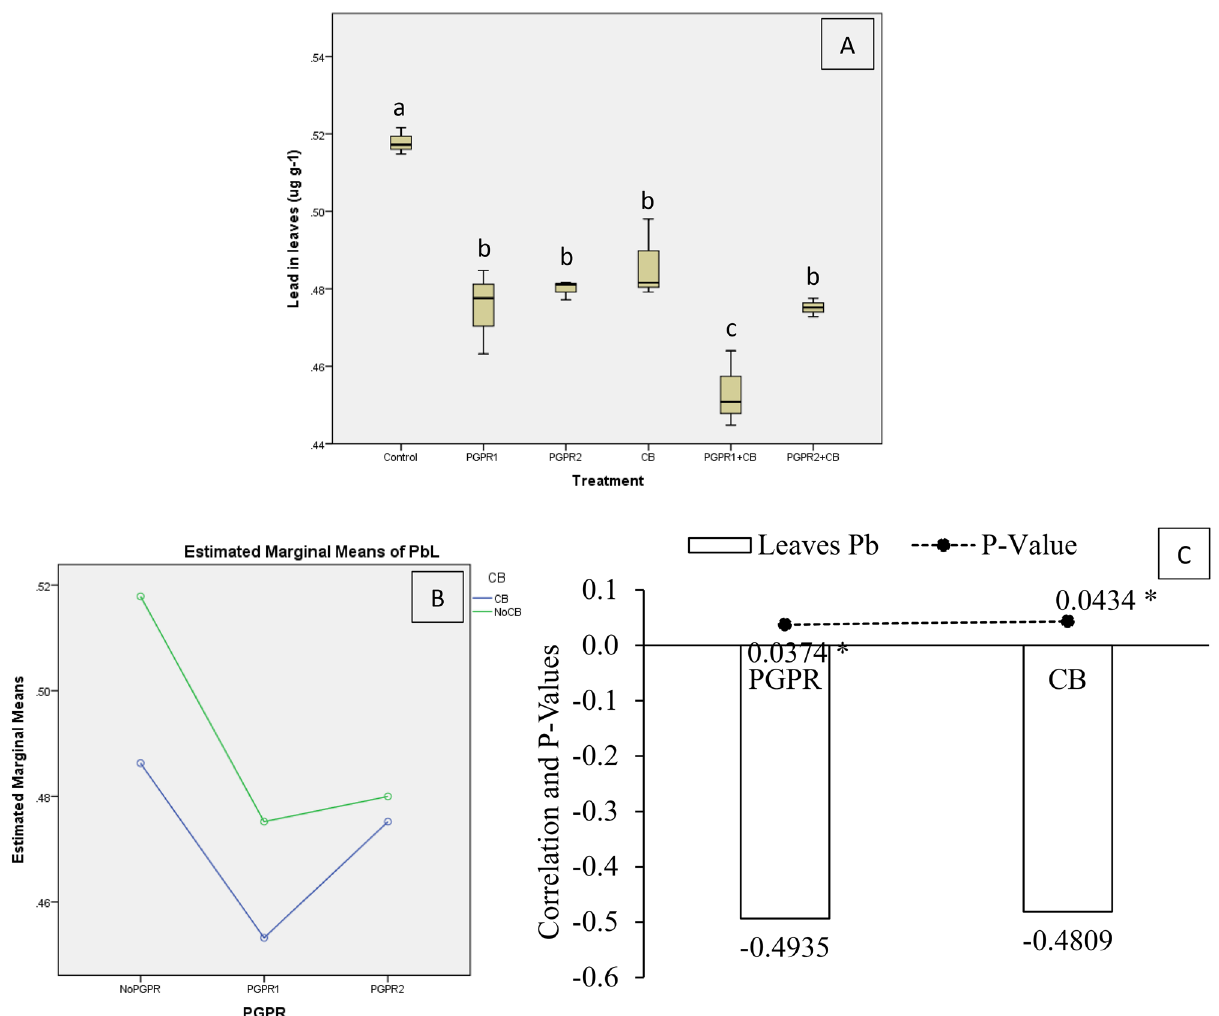
Figure 15. Effect of treatments on mint plants leaves lead concentration (PbL). Values are the average of three replicates ( A ). Different letters showed significant differences (Tukey’s test; p ≤ 0.05). Interaction graph of PGPR and CB for PbL ( B ). Correlation graph of PGPR and CB for PbL ( C ).